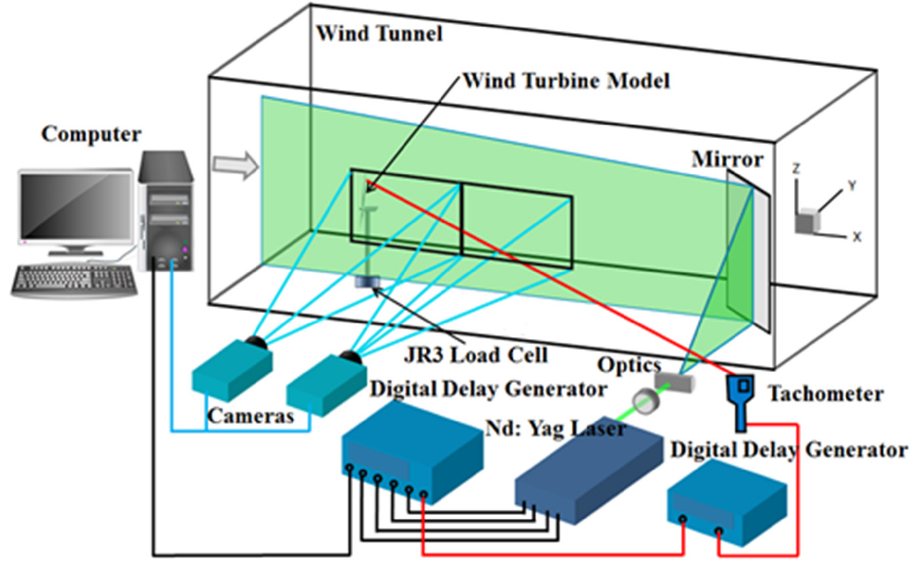
Figure 4. Experiment setup for “free run” and “phase-locked” PIV measurements.